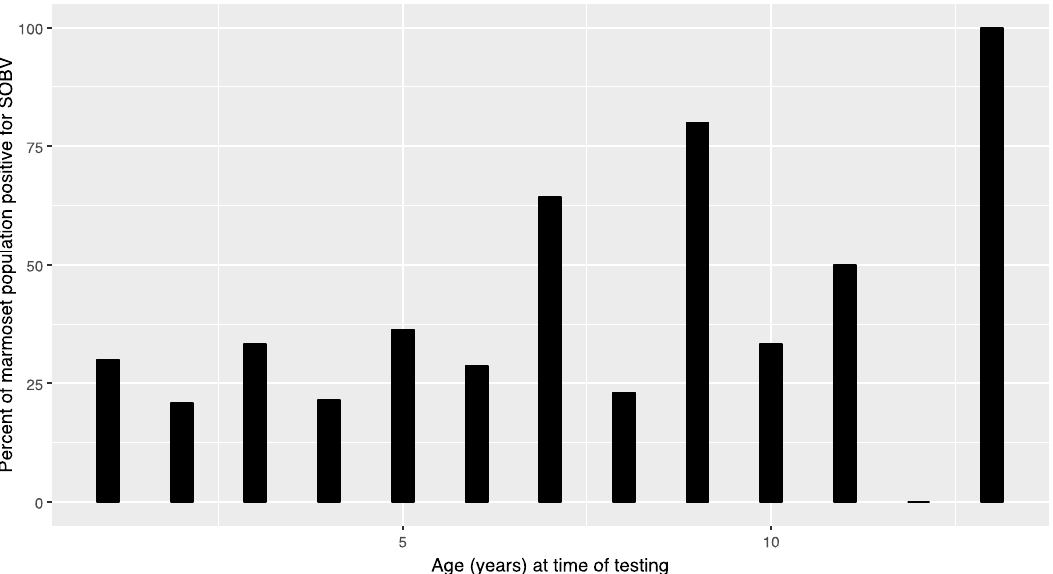
Figure 4. Prevalence of infection with SOBV in common marmosets at the WNPRC increases with age. One hundred forty-six live, clinically normal common marmosets in the WNPRC captive common marmoset colony were screened for SOBV using RT-PCR and deep-sequencing methods. The likelihood of infection with these viruses was significantly statistically associated with increasing age ( p = 0.03237) using univariate logistic regression.